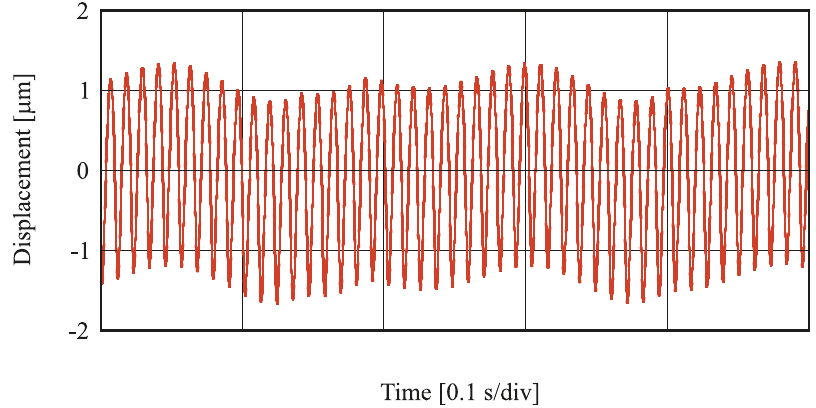
Figure 12. A close look at the displacement around the steady ‐ state position.